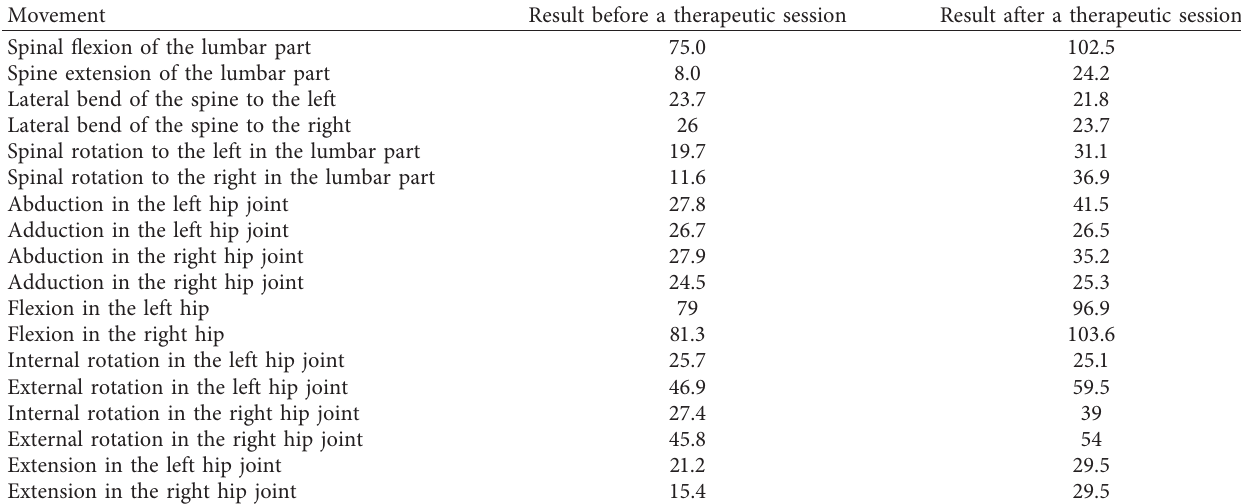
Figure 3: The exemplary result of the range of motion in the lumbar part, flexion/extension, lateral flexion to the left/right, and rotation to the left/right: the result (a) before a therapeutic session and (b) after a therapeutic session. Table 1: The report generated before and after a therapeutic